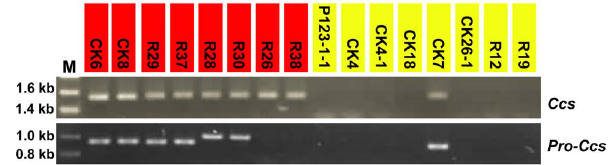
Figure 3. PCR amplification of the Ccs gene and its promoters from the genomes of the indicated Capsicum varieties. The order of the pepper lines is the same as in Figure 1, and the mature fruit colors are indicated with red and yellow